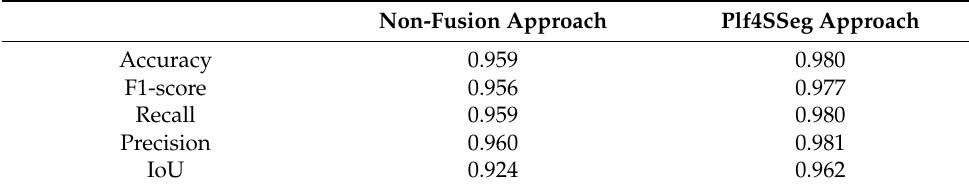
Table 2. Comparison of the Plf4SSeg approach and the non-fusion approach.